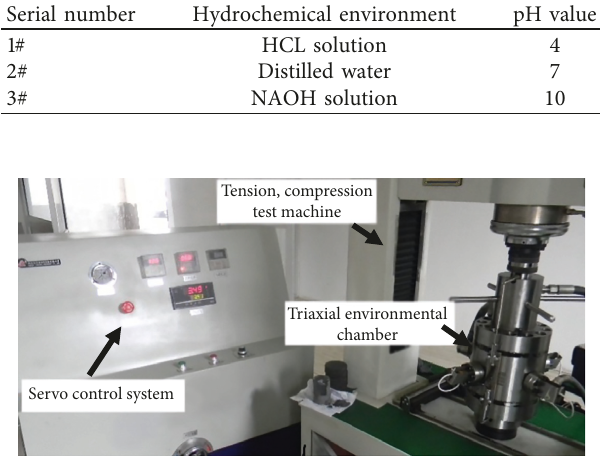
Figure 2: Triaxial creep test